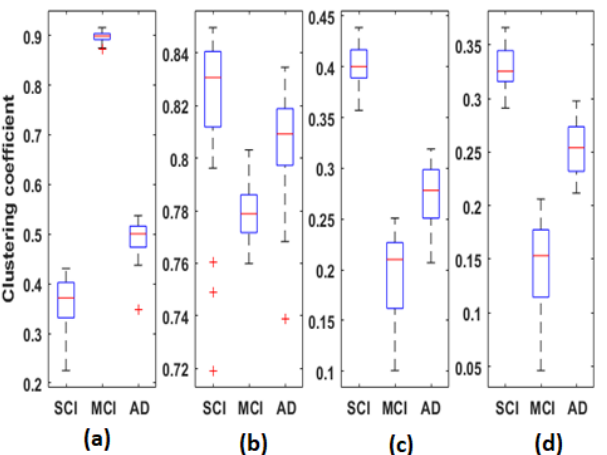
Figure 9. Boxplots of the local clustering coefficient values computed for each average EpEn matrix of SCI, MCI and AD on the ( a ) delta, ( b ) theta, ( c ) alpha and ( d ) beta bands.